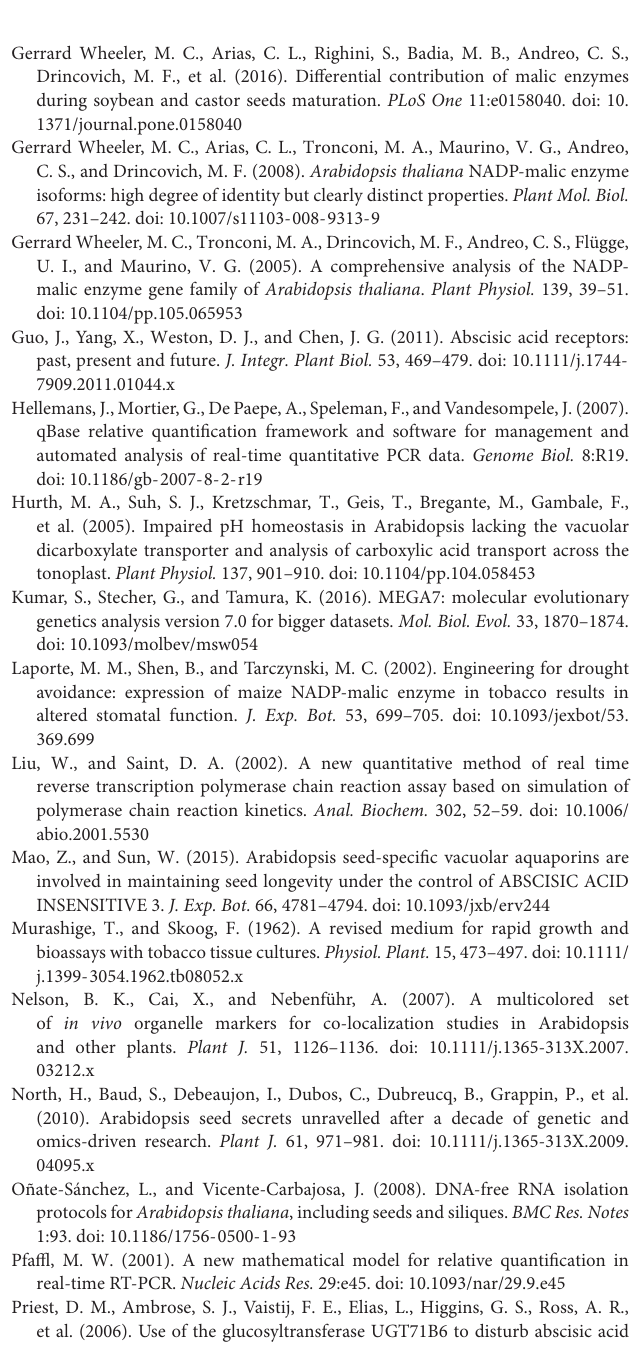
TABLE S2 | Location of motifs in the promoters and 5 (cid:48) UTR of the genes selected. TABLE S3 | Location of motifs in the promoters and 5 (cid:48) UTR of NADP-ME genes from P. patens